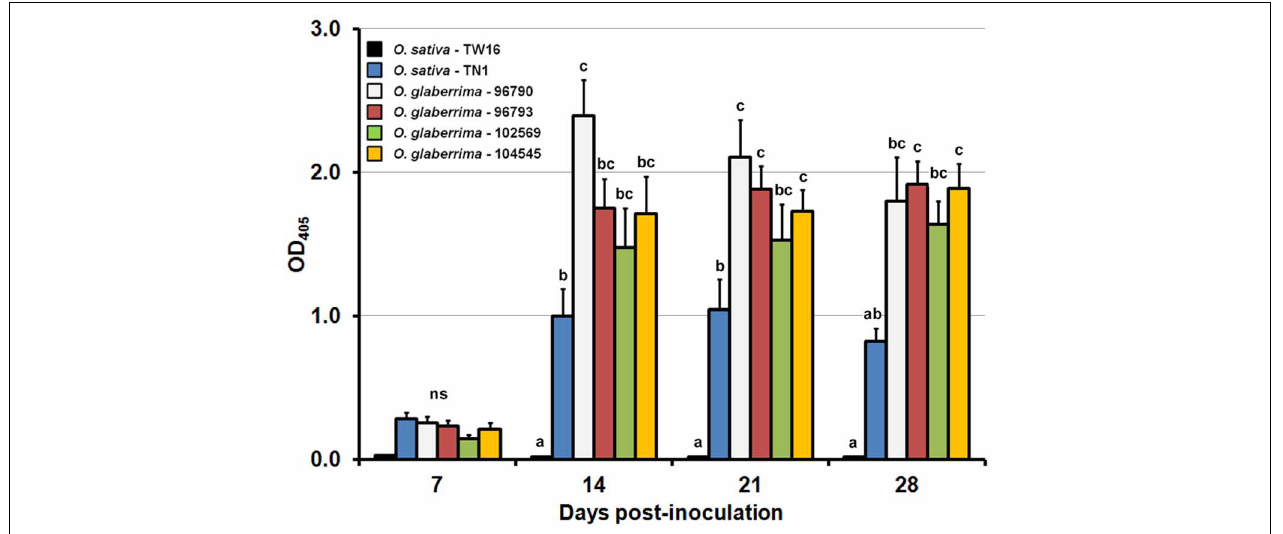
FIGURE 2 | Temporal changes in the accumulation of Rice tungro spherical virus in plants of Oryza glaberrima and O. sativa . Vertical bars and vertical lines indicate means and standard errors of mean, respectively, for the absorbance at 405nm at the respective time points. Means and standard errors of mean were based on three